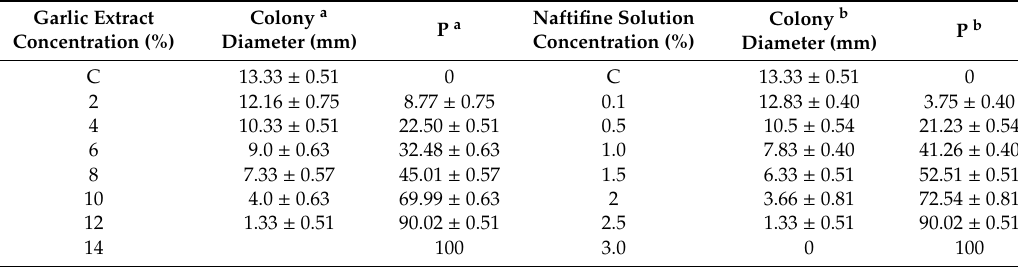
Table 2. In vitro e ff ect of A. sativum extract and naftifine against R. mucilaginosa isolate using the agar dilution